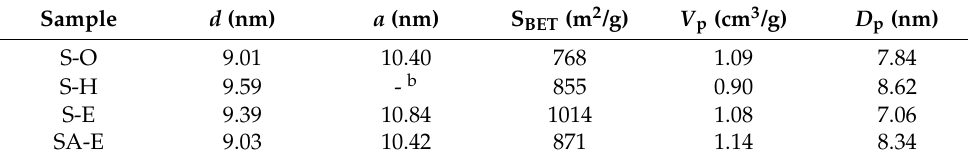
Figure 3. Small-angle ( a ) and wide-angle ( b ) XRD patterns of Samples S-O, S-H, S-E, and SA-E. Figure 3. Small - angle ( a ) and wide - angle ( b ) XRD patterns of Samples S - O, S - H, S - E, and SA - E . Table 2. Physicochemical properties of Samples S-H, S-E, and SA-E a . Table 2. Physicochemical properties of Samples S - H, S - E, and SA - E a . Sample